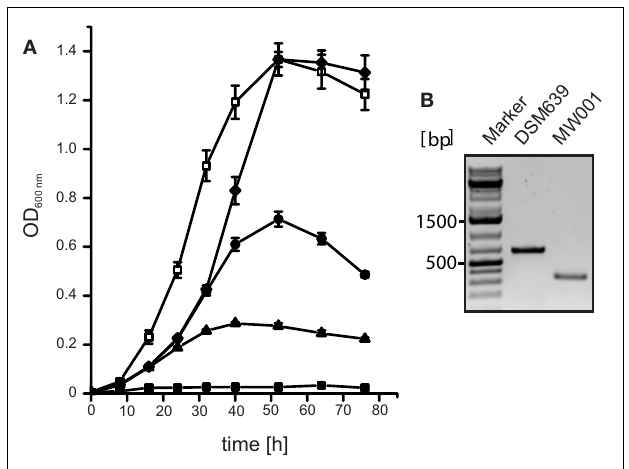
FIGURE 1 | Construction of the uracil auxotrophic strain MW001. (A) Growth curves of MW001 in medium containing 0.2% NZ-amine and 0 (closed rectangles), 1 (closed triangles), 2.5 (closed circles), 5 (closed diamonds), 10 μ g/ml (open rectangles) uracil. (B) PCR analysis of the wild type S. acidocaldarius strain DSM 639 and MW001 using primers 914/915 that amplify 663bp of the full length pyrE and 340bp from the deletion mutant pyrE